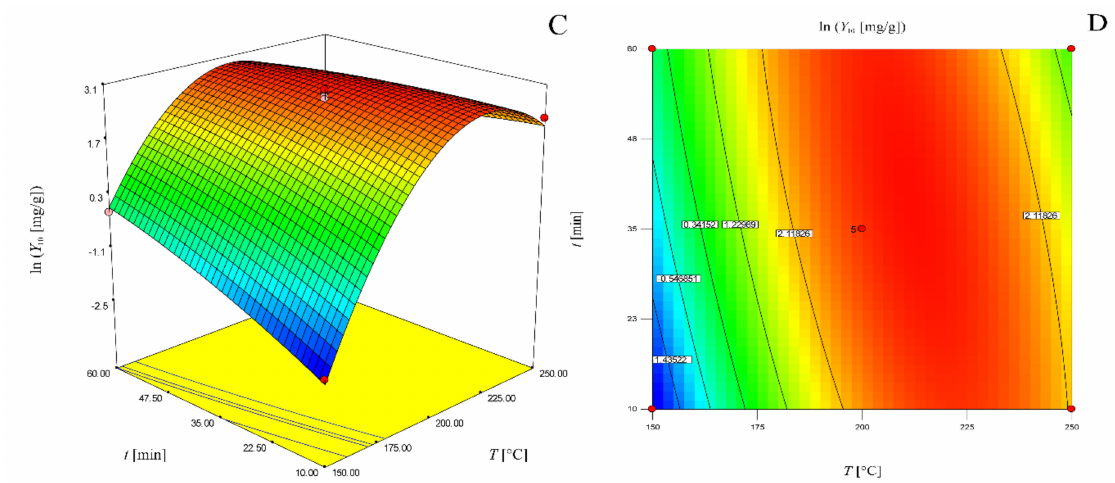
Figure 5. Three-dimensional response surface ( a ) and two-dimensional contour plot ( b ) of the model for determination of 5-HMF yield for a solvent–solid ratio of 20 mL / g; three-dimensional response surface ( c ) and two-dimensional contour plot ( d ) of the model for determination of furfural yield for a solvent–solid ratio of 20 mL /